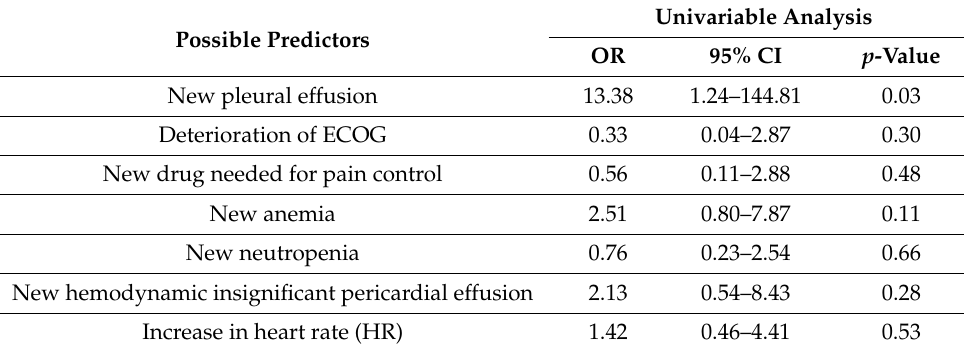
Table 2. Clinical possible predictors of lung cancer